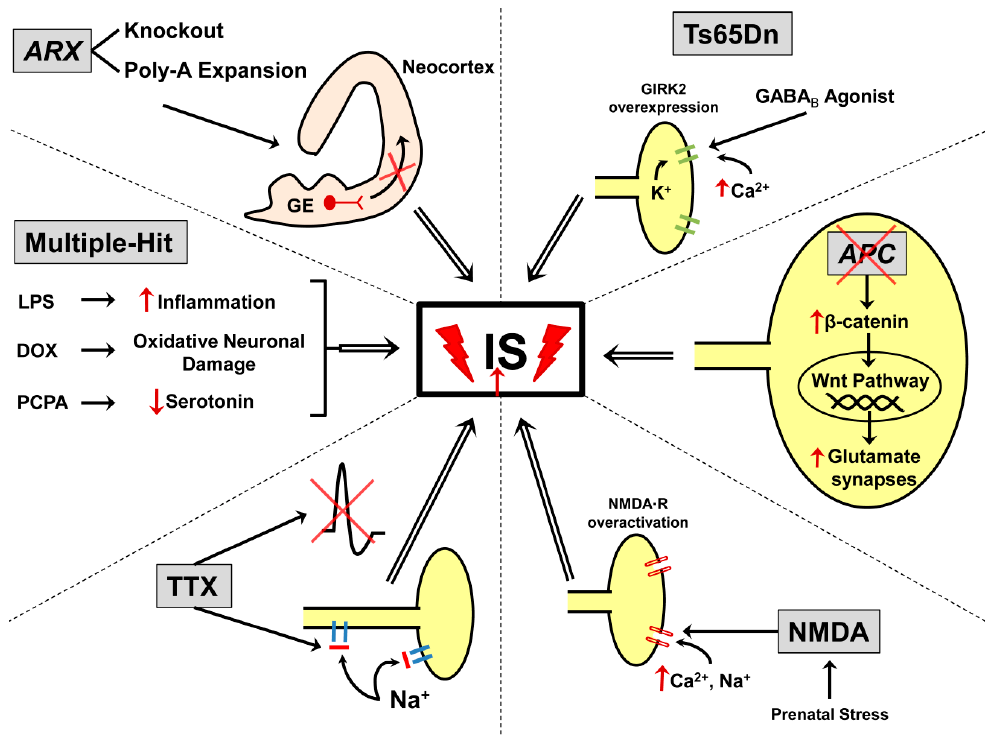
Figure 1. Sites of potential pathophysiology of IS in selected animal models. Neuronal somata and axons are shown in yellow. Top left, Selective mutation of ARX (knockout or knock-in (poly-alanine expansion)) from cortical interneurons leads to abnormalities of GABAergic interneuron migration and function. Top right, In the Ts65Dn Down syndrome model, there is dysfunction of the inward rectifying potassium channel, GIRK2, which might allow excessive Ca 2+ influx and hyperexcitability; GABA B receptor agonists induce spasms in this model. Middle right, Conditional deletion of APC leads to increased β -catenin levels, increased number of glutamatergic synapses, and development of IS. Bottom right, Prenatal stress (such as immobilization stress or betamethasone exposure) alters expression of genes involved in excitatory and inhibitory synaptic function; postnatal injection of NMDA causes hyperactivation of glutamate receptors and increased Ca 2+ influx. Bottom left, TTX infusion blocks Na + channels of both axons and somata, inhibiting neuronal firing in neocortex, which becomes essentially deafferented by this drug; spasms then begin in the hemisphere contralateral to the TTX injection. Middle left, Multiple-hit model uses the combination of the antineoplastic drug DOX, the pro-inflammatory agent LPS, and the serotonin-depleting compound PCPA to induce large cortical structural lesions, replicating some features of severe symptomatic IS. See text for details. Abbreviations: IS, infantile spasms; GE, ganglionic eminence; ARX, Aristaless-related homeobox gene; poly-A, poly-alanine; GIRK2, G-protein coupled rectifying potassium channel type 2; GABA B -R, γ -aminobutyric acid receptor type B; APC, adenomatous polyposis coli; NMDA-R, N-methyl-D-aspartate receptor; Ca 2+ , calcium; Na + , sodium; K + , potassium; TTX, tetrodotoxin; DOX, doxorubicin; LPS, lipopolysaccharide; PCPA, p-chlorophenylalanine .